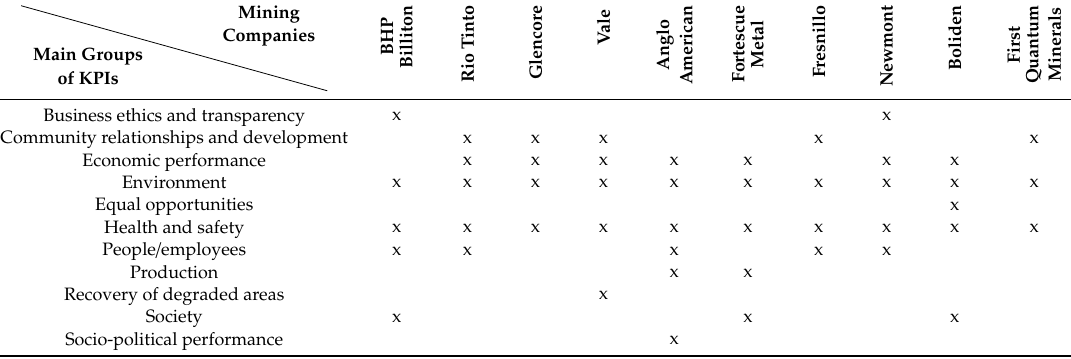
Table 2. KPIs monitored by the selected mining